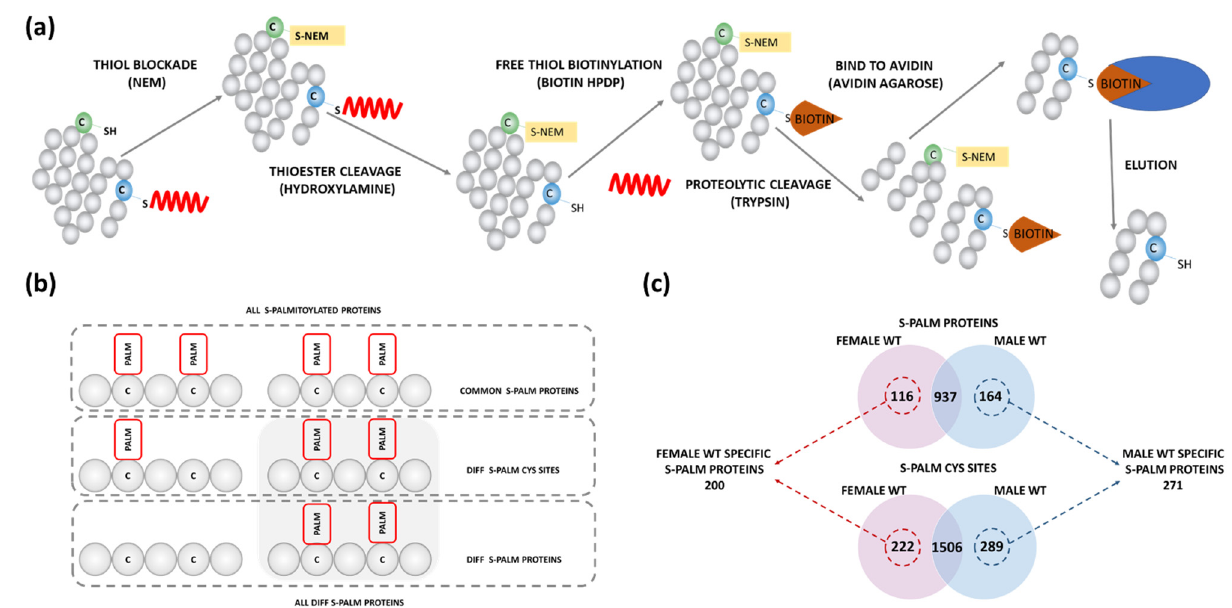
Figure 2. Sex-dependent analysis of protein S-PALM in synaptoneurosomes isolated from female and male WT mice. ( a ) Scheme of PANIMoni mass spectrometry-based method. ( b ) Scheme of S-PALM analysis showing differential and sequential S-PALM classification. ( c ) Venn diagram analysis of differential S-PALM in female and male synaptoneurosomes (Nmice = 3/group).